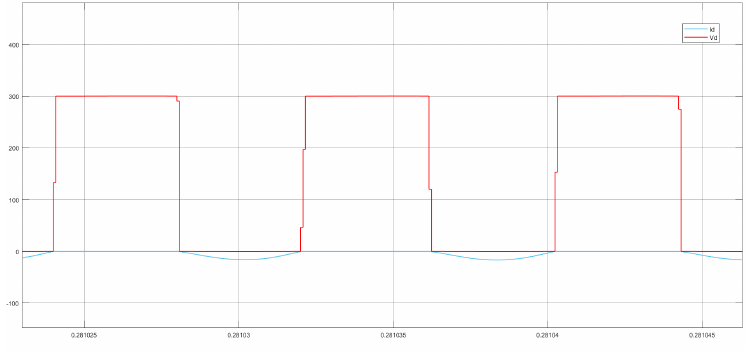
Figure 7. The voltage and current waveforms of the secondary.